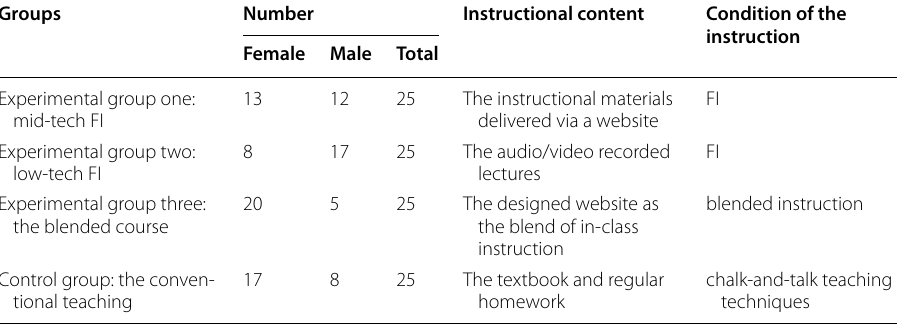
Table 1 The participants of the study and their class condition Groups